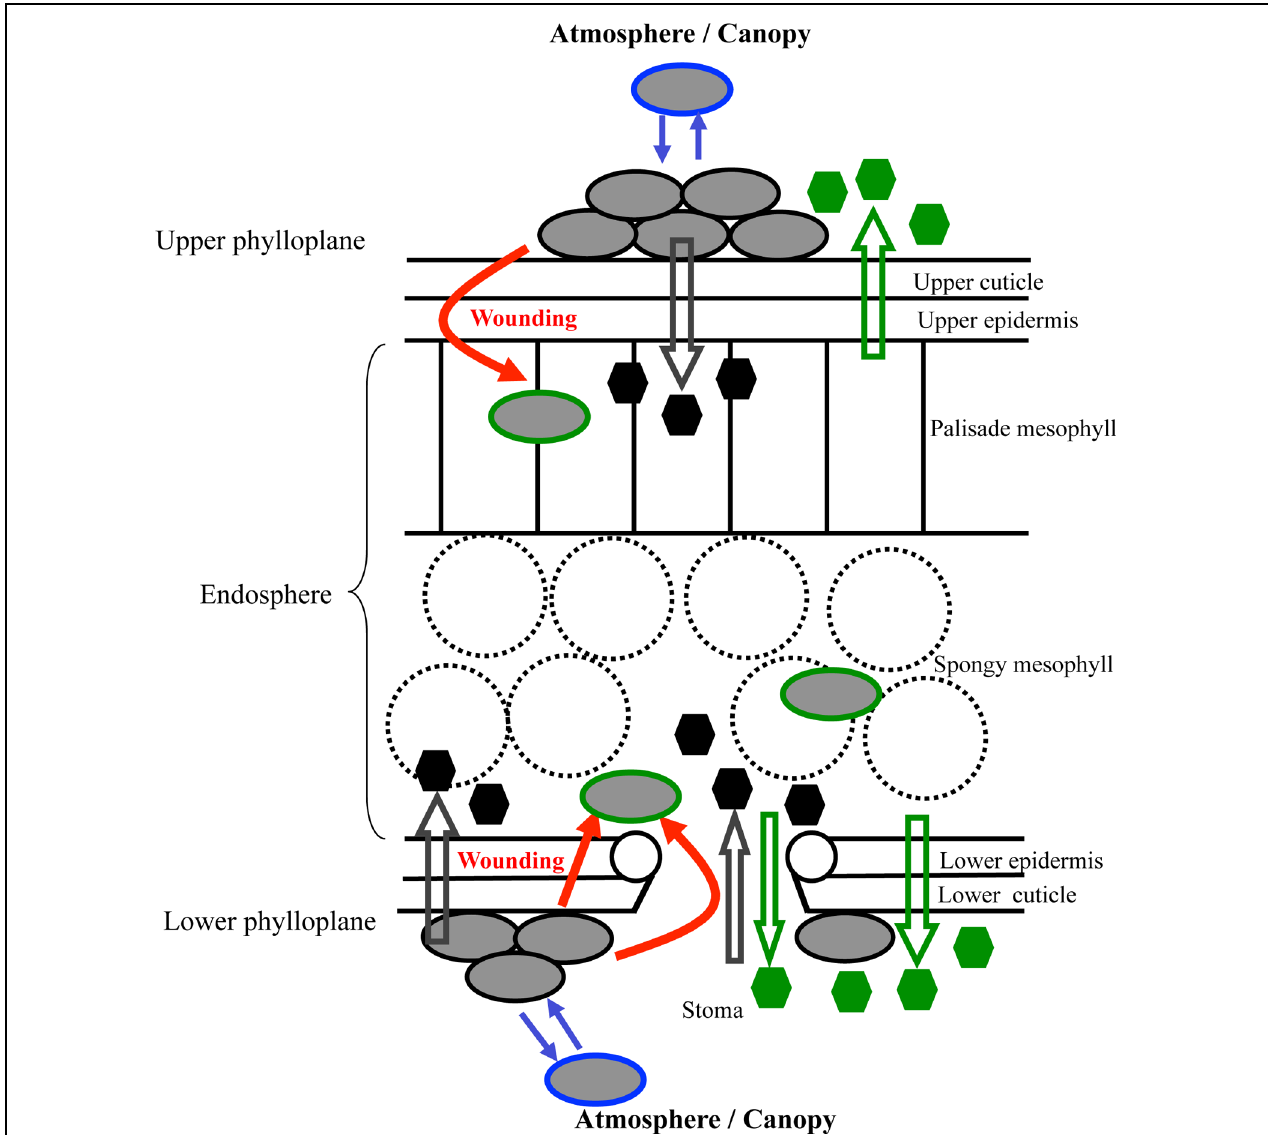
FIGURE 1 | General histological features and biochemical exchanges of the phylloplane. The schematic leaf cross section shows interactive exchanges (solid arrows) involving epiphytic microorganisms (gray ellipsoids with black edge) or endophytic microorganisms (gray ellipsoids with green edge) and leaf structures. It also shows the potential fluxes of plant (open green arrows)